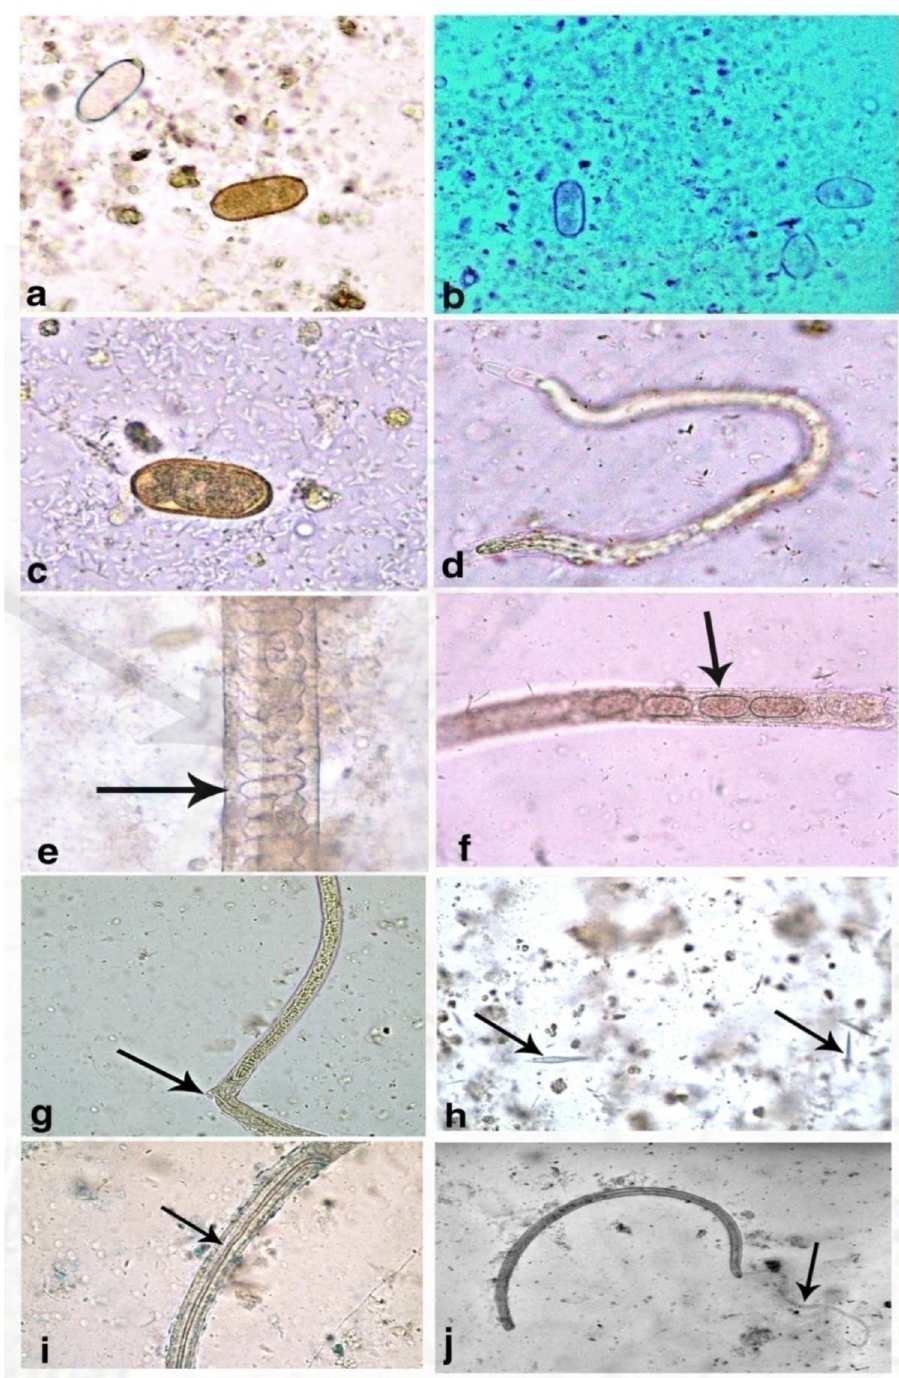
Fig 1. Microscopic examination of C . philippinensis showing different stages. A) Thick and thin-shelled egg; b) Swollen egg; c) Emberyonated egg; d) Sheathed larva; e) Adult female anterior end showing esophagus with stichocytes; f) adult female uterus containing eggs; g) Vulva of an adult female; h) Charcot–Leyden crystals; i) Posterior end of adult male showing transparent sheath containing spicule; j) Posterior end of adult male with projecting spicule.